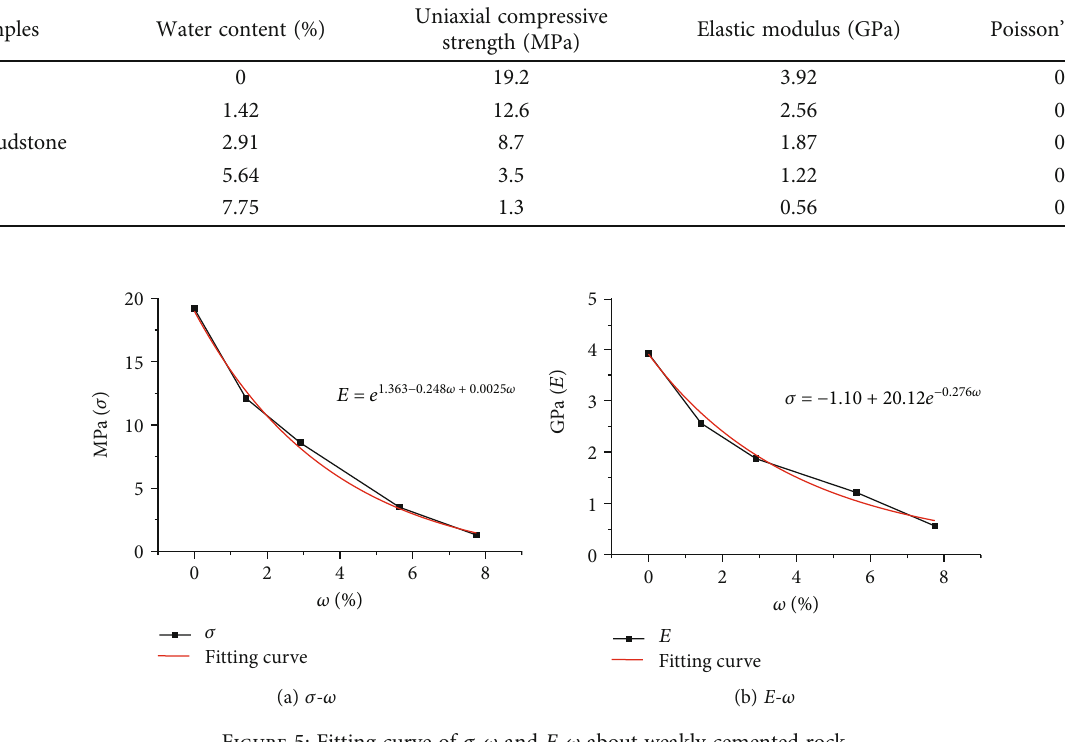
Figure 5: Fitting curve of σ - ω and E - ω about weakly cemented rock.